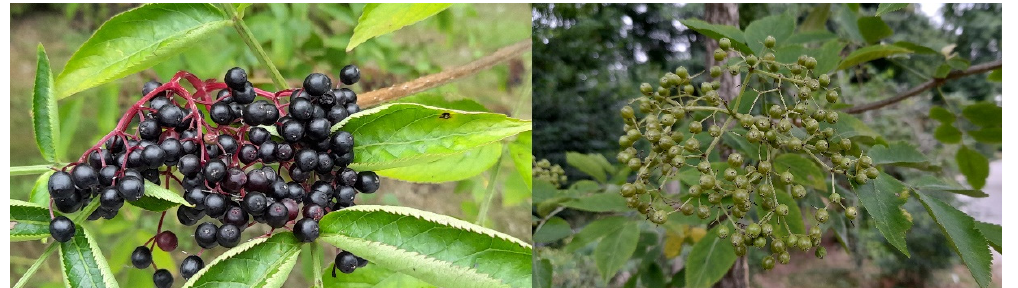
Figure 7. Plant material for the study. On the left picture are fruits of Sambucus nigra var. nigra, and on the right picture are fruits of Sambucus nigra var. viridis on the third sampling date (29